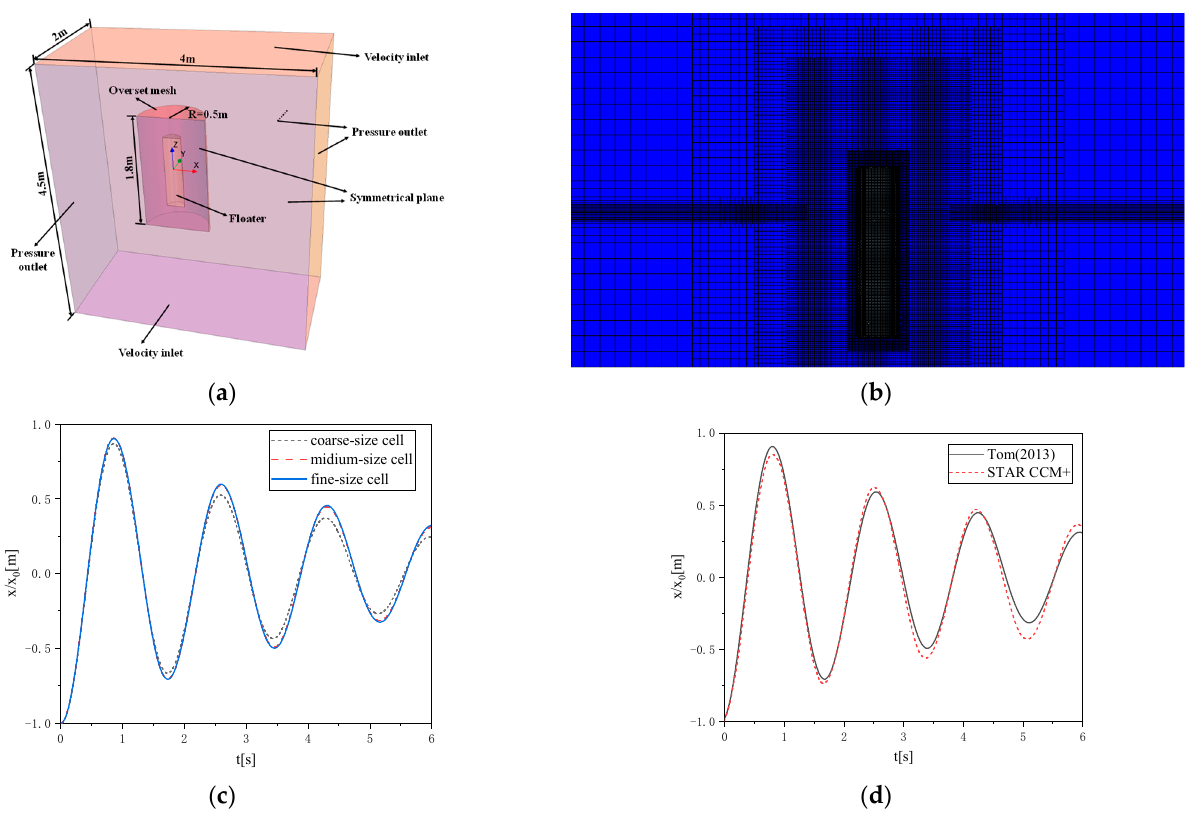
Figure 2. Validation of the numerical calculation results of STAR CCM+: ( a ) calculation domain and boundary conditions in STAR CCM+; ( b ) mesh generation in STAR CCM+; ( c ) comparison of simulation results of cells with different sizes; ( d ) comparison between numerical calculation and experimental data.